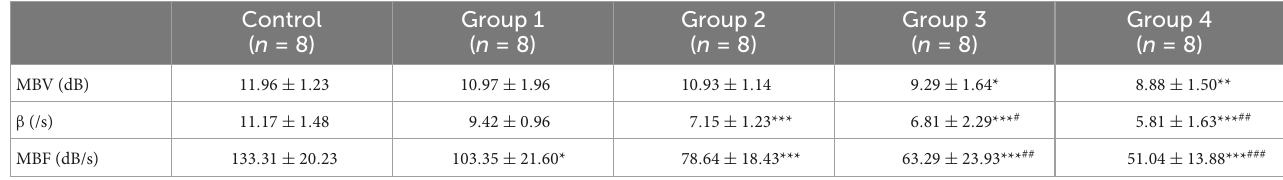
TABLE 3 Changes in perfusion parameters by